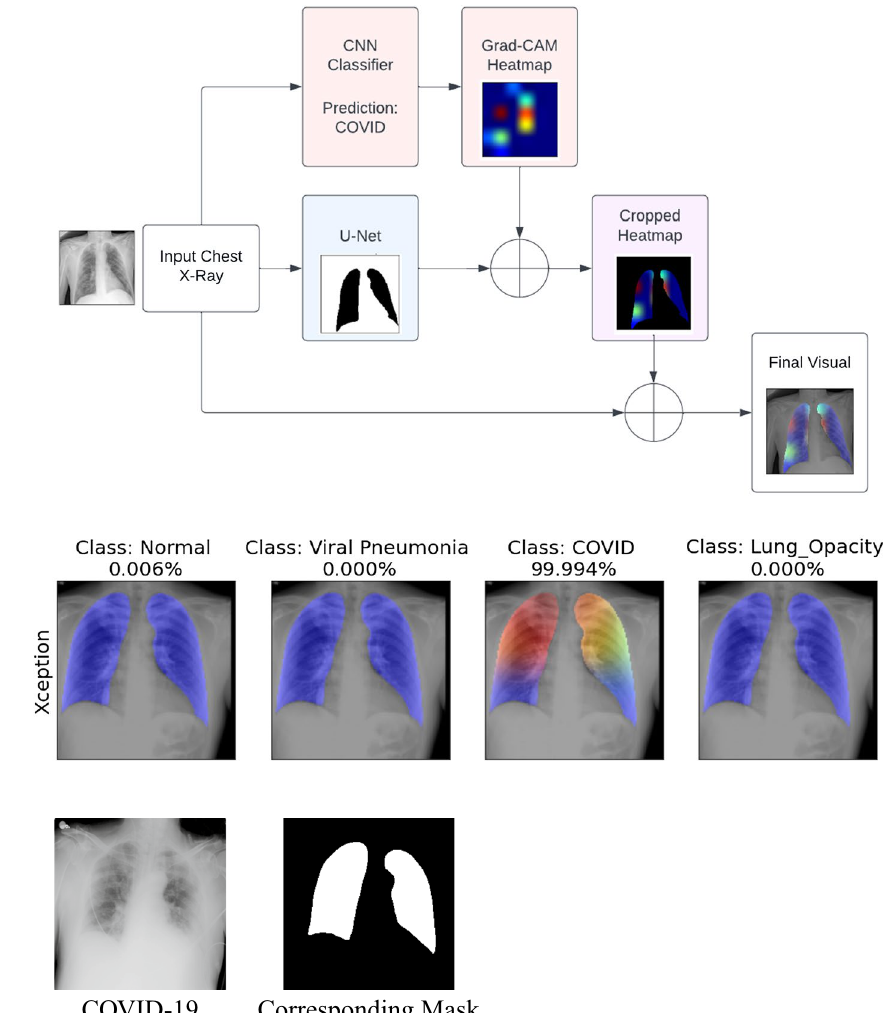
Fig. 3 Example chest X-ray. This is a sample X-ray from training data. The plot on the right is a 2D array with values of 1 representing lungs and 0 representing not lungs. This allows the mask to be multiplied with the original image element wise to crop out the lungs without the heart in the middle or the remaining